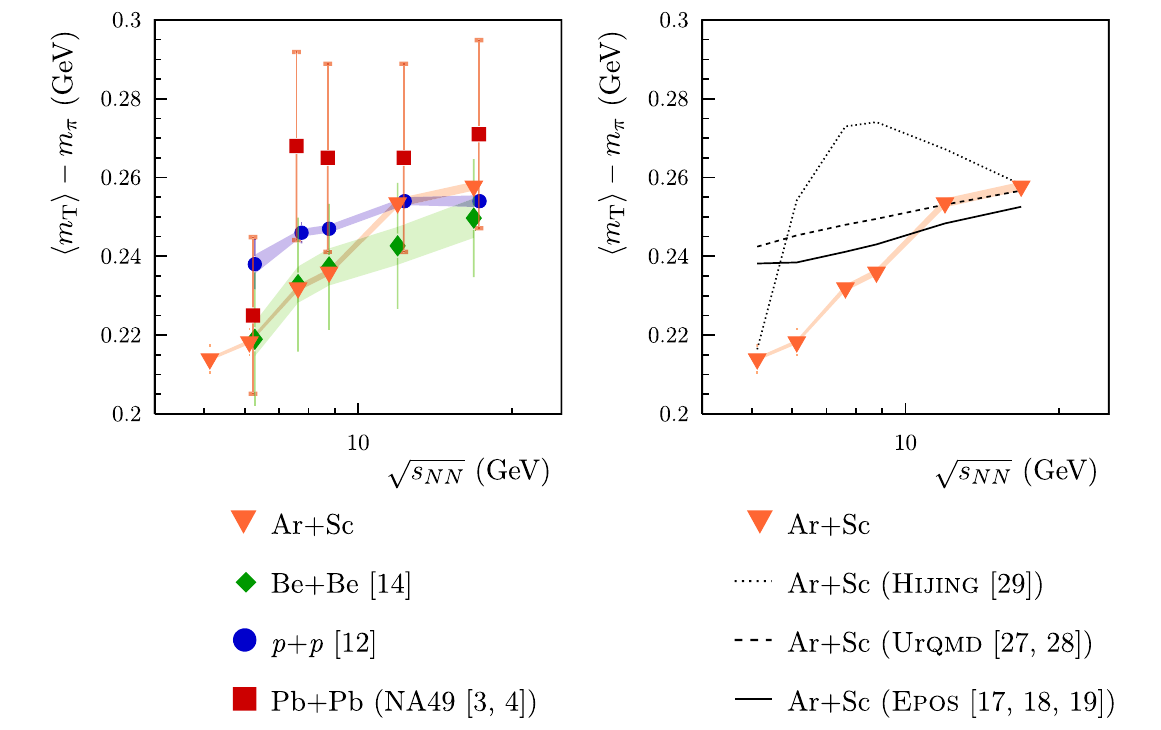
Fig. 15 Left: average transverse mass (cid:5) m T (cid:6) − m π at mid-rapidity (0 < y < 0 . 2) versus the collision energy. The results are compared with the corresponding data on inelastic p + p , central Be+Be and cen- tral Pb+Pb collisions. Statistical uncertainties are shown as vertical bars